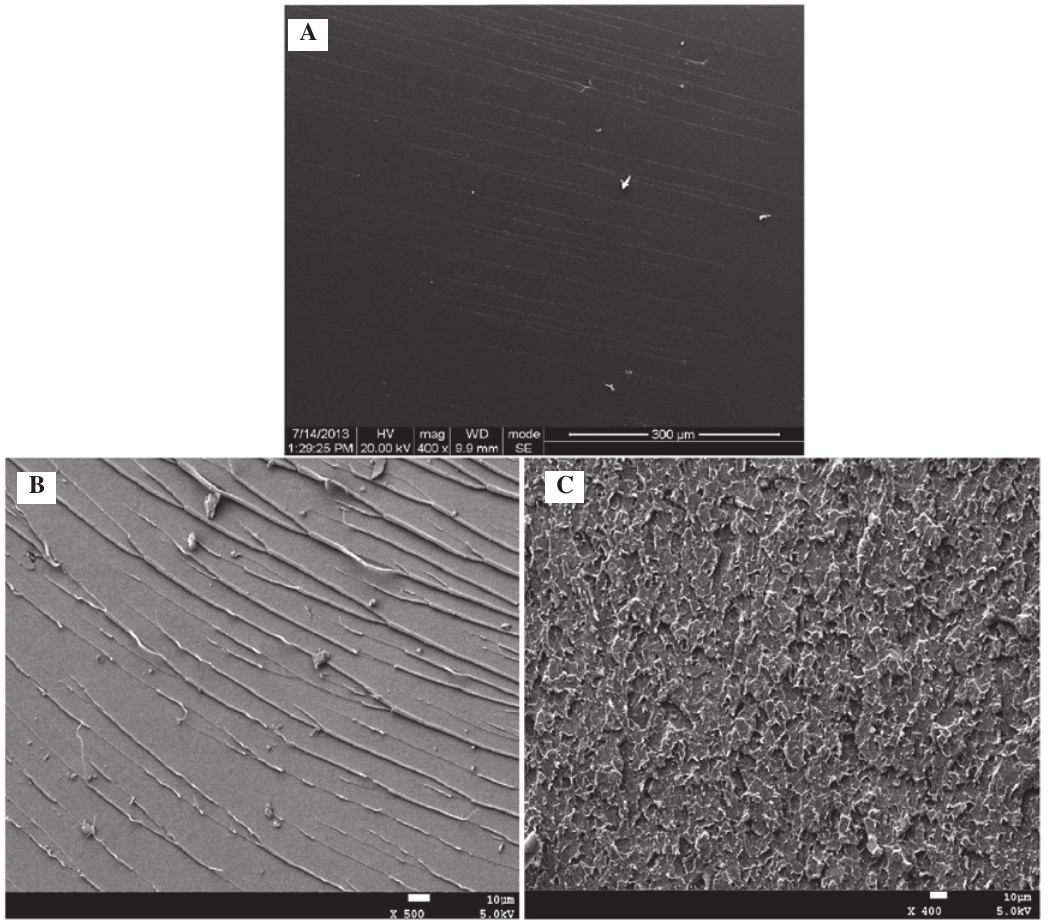
Figure 10: SEM micrographs of 0% (A), 10% (B), and 15% (C) BAPh/PEN-OH